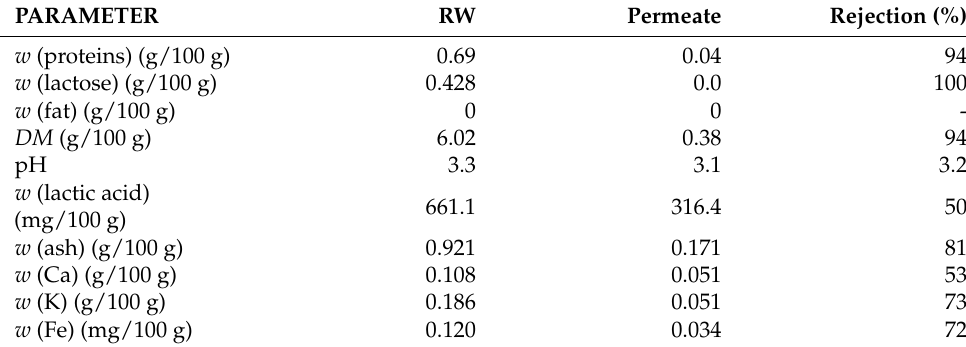
Table 5. Measured chemical parameters after nanofiltration.